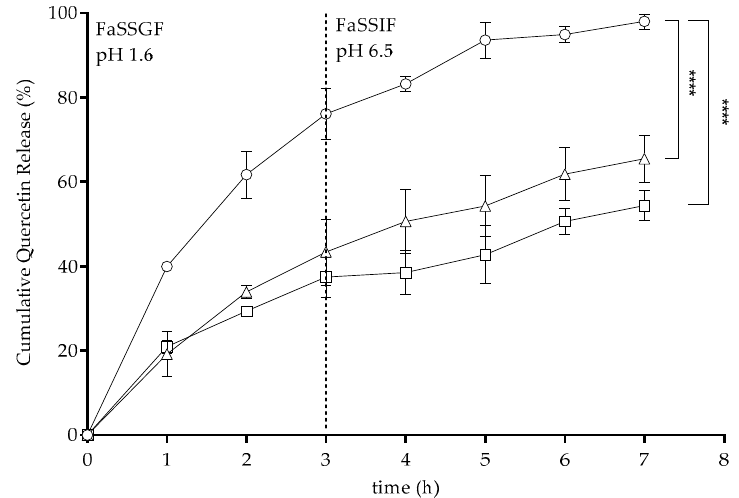
Figure 3. In vitro release of quercetin from loaded 1F/1C (circles), 3F/1C (triangles), and 5F/1C (squares) nanoparticles under simulated gastrointestinal conditions using fasted-state simulated gastric fluid (FaSSGF) and fasted-state simulated intestinal fluid (FaSSIF) at physiological temperature (37 °C). Data points correspond to means ± standard deviation for n = 3 replicates; **** p < 0.0001.